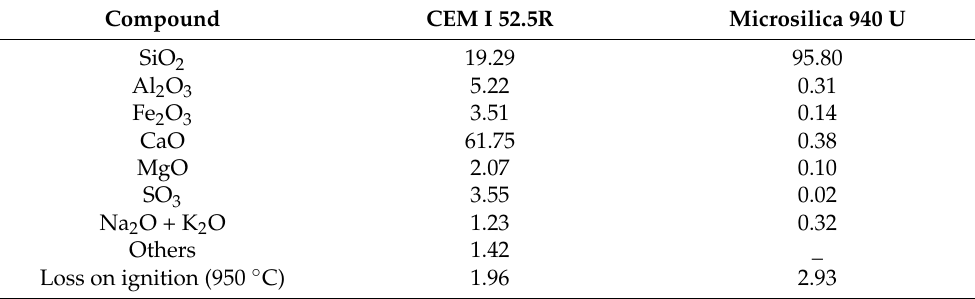
Table 1. Chemical composition of CEM I 52.5R and silica fume (% in weight).